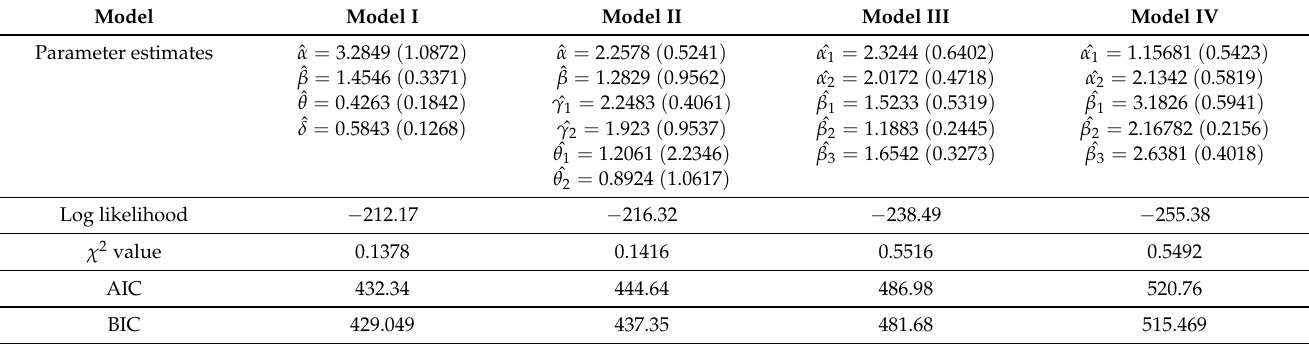
Table 3. Parameter estimates for Data Set II.